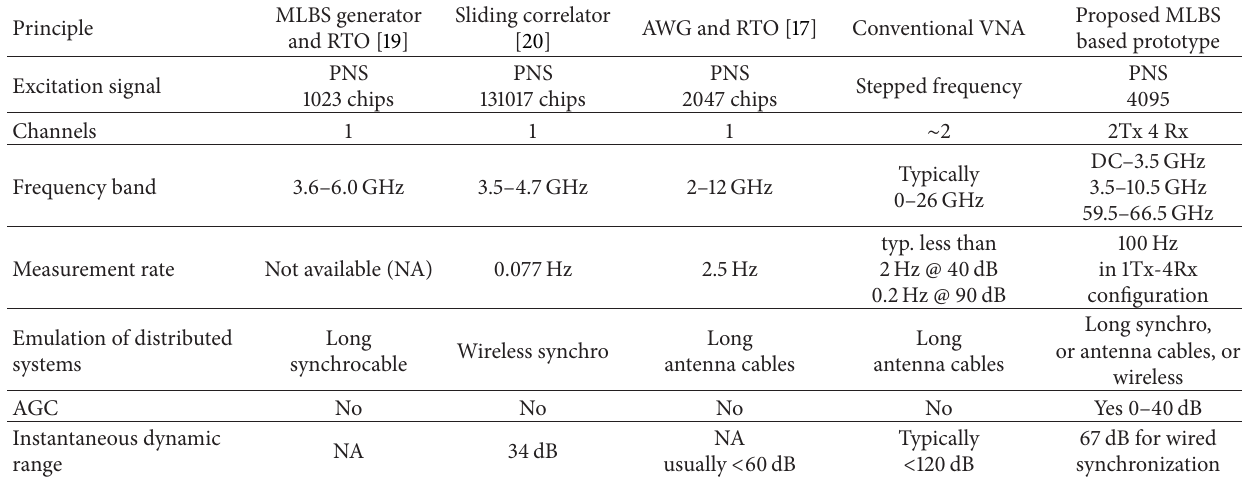
Table 1: Comparison of UWB channel sounding